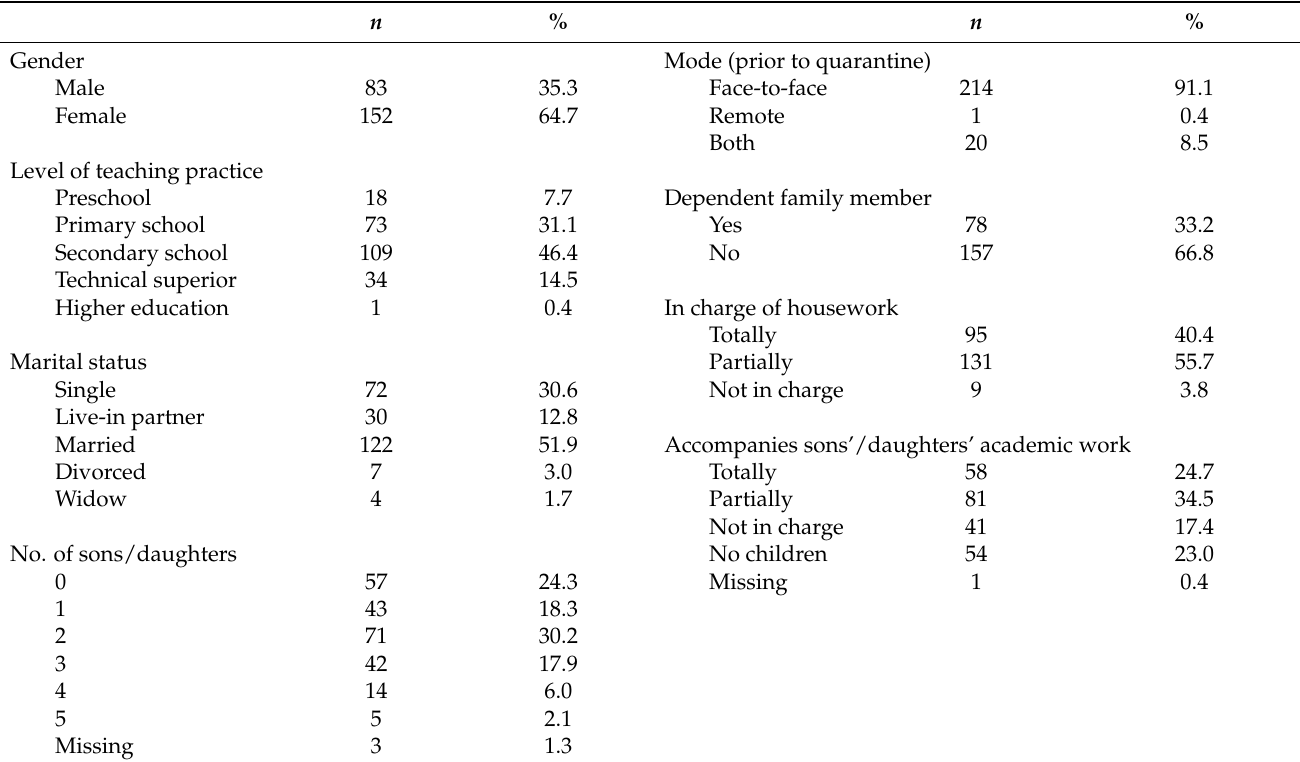
Table 1. Distribution of participants by sociodemographic